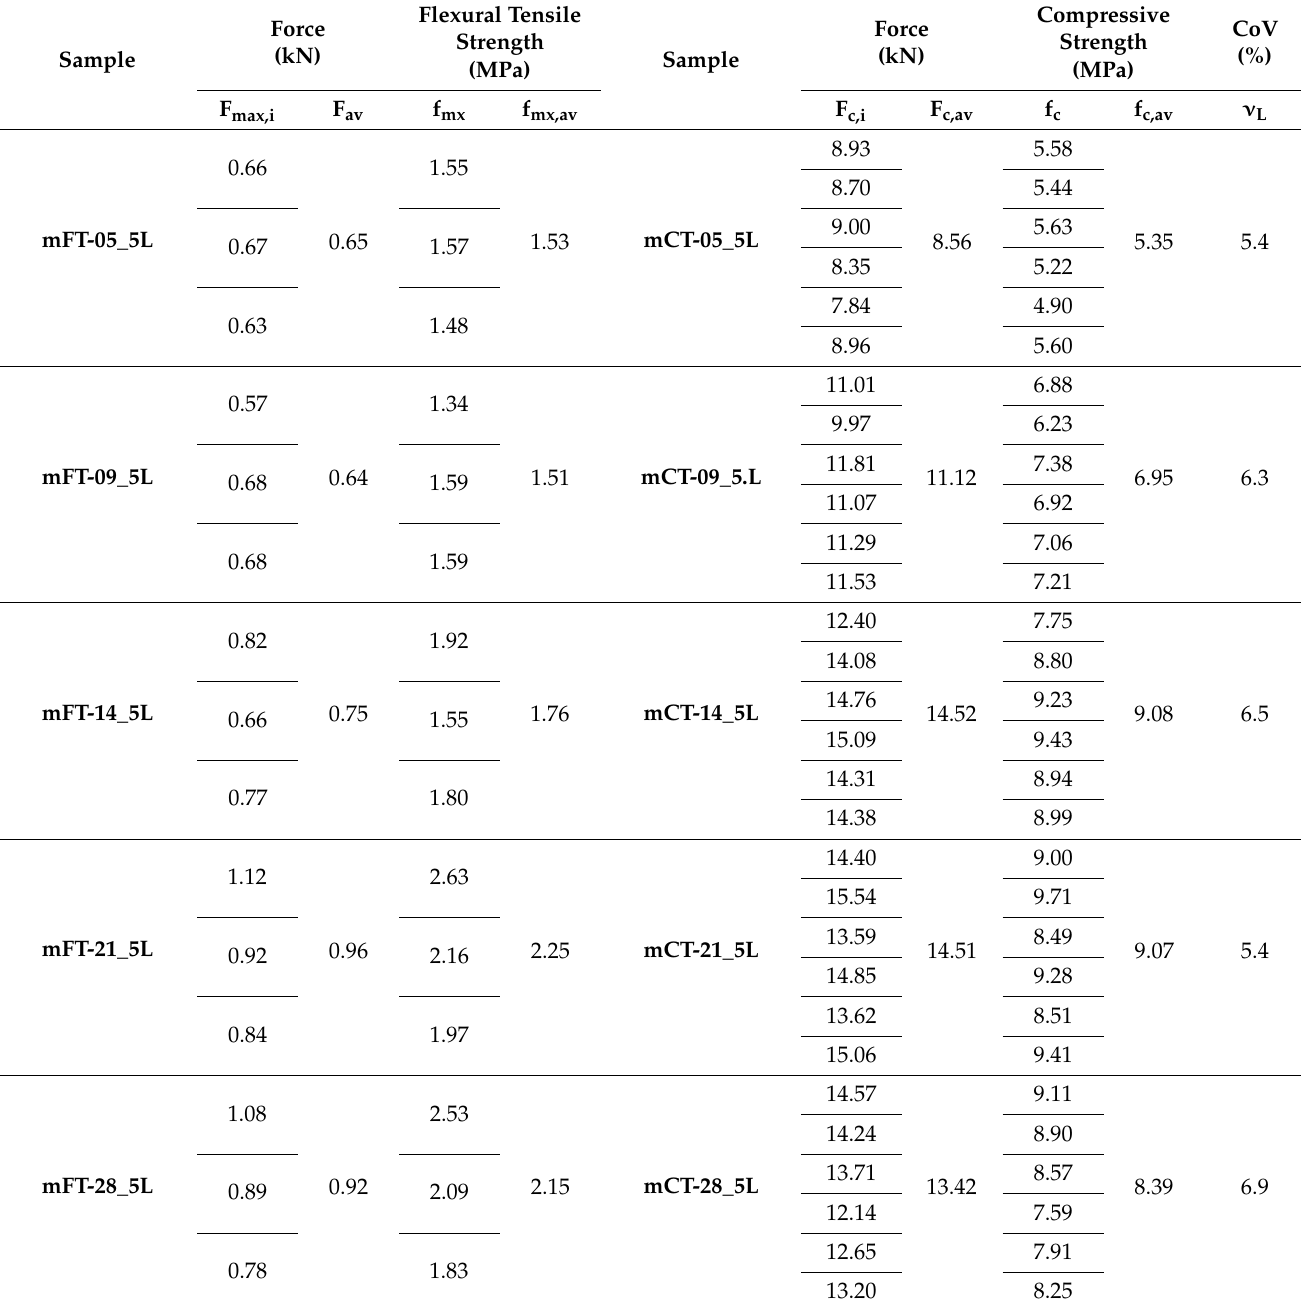
Table 4. Flexural and compressive strengths—mortar made with 5 L of mixing water per 25 kg